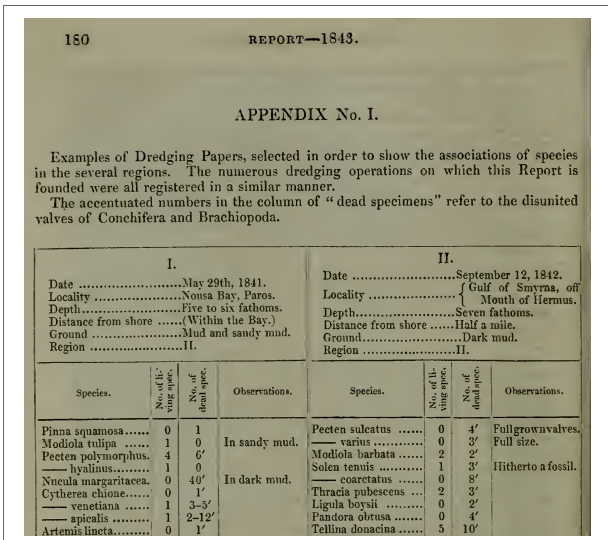
FIGURE 4 | A screenshot of the dataset used where the structure of the data and metadata provided can be seen (page 180 from Forbes,